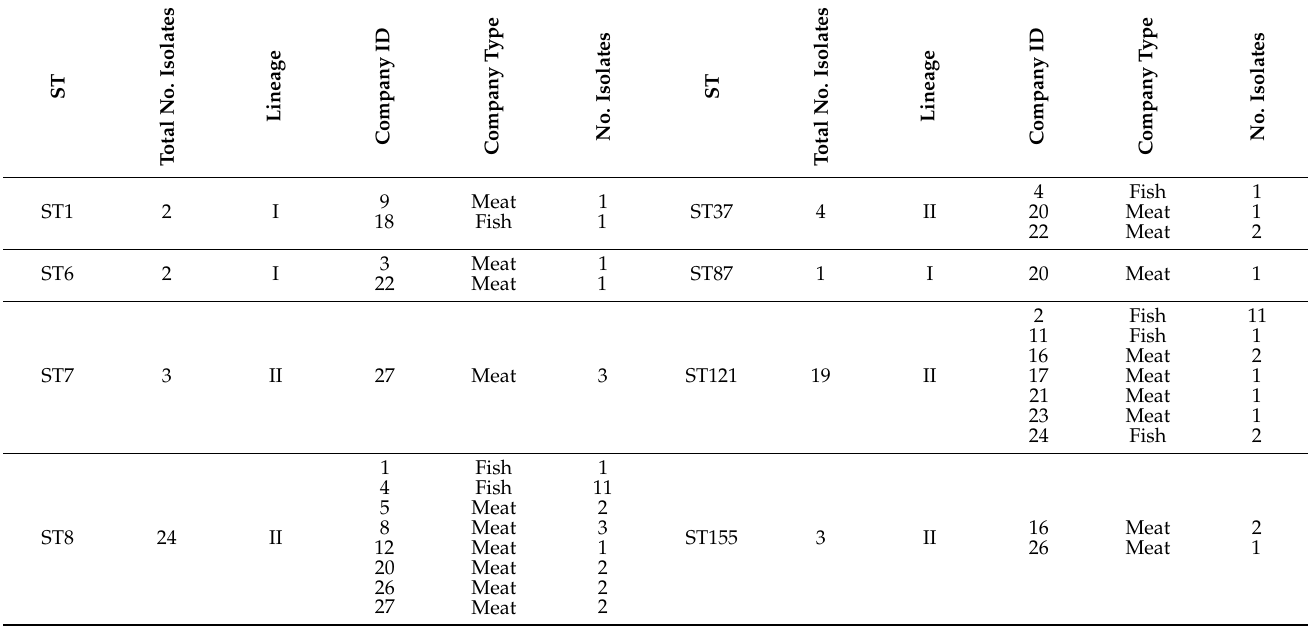
Table 3. Overview of the STs of 85 Listeria monocytogenes isolates obtained from the food processing environment and products between 2016 and